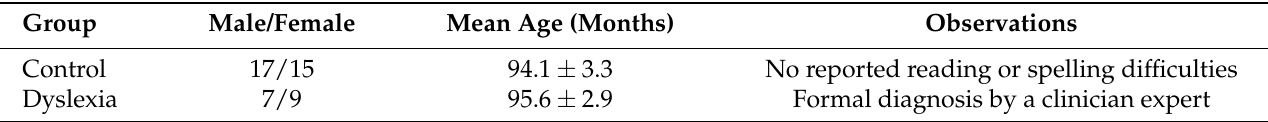
Table 1. Database. Age range: 88–100 ( t ( 1 ) = − 1.4, p > 0.05).